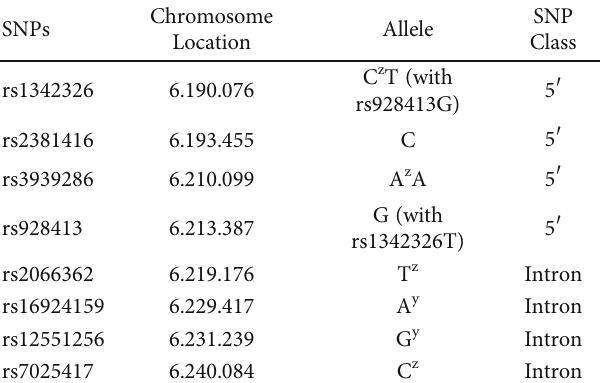
Table 2: Some important IL-33 SNPs associated with asthma.